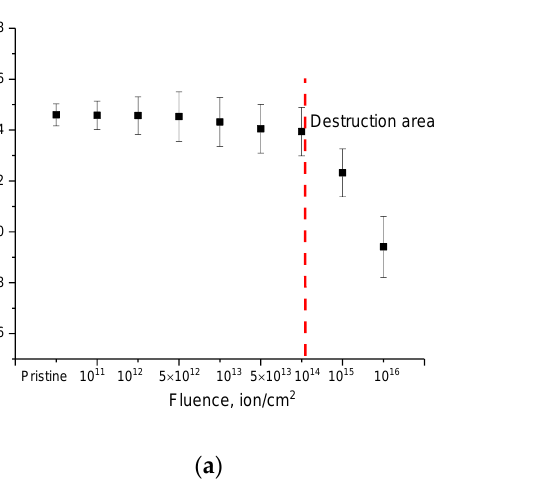
Figure 10. ( a ) Results of changes in the thermal conductivity value depending on the irradiation fluence; ( b ) dependence of the change in heat losses on the porosity of ceramics subjected to irra-